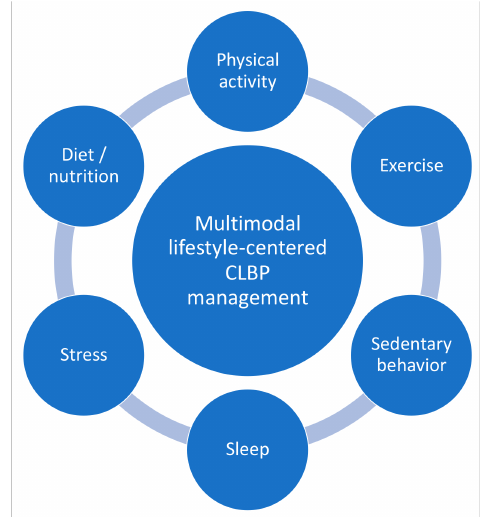
Figure 1. Promising direction for further research: a multimodal lifestyle-centered approach for people with chronic low back pain